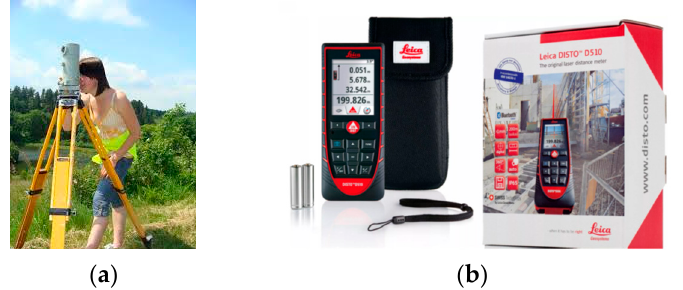
Figure 7. The measuring devices: ( a ) a precise leveler; ( b ) a distance meter.